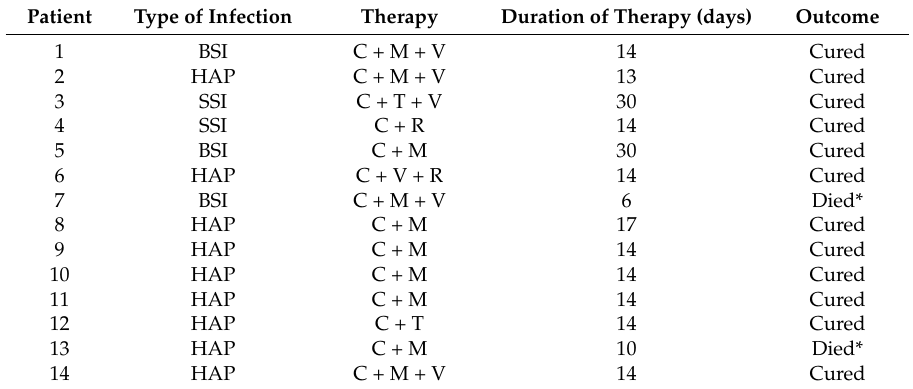
Table 1. Clinical characteristics of patients ( n = 14) with CR-Ab infection.